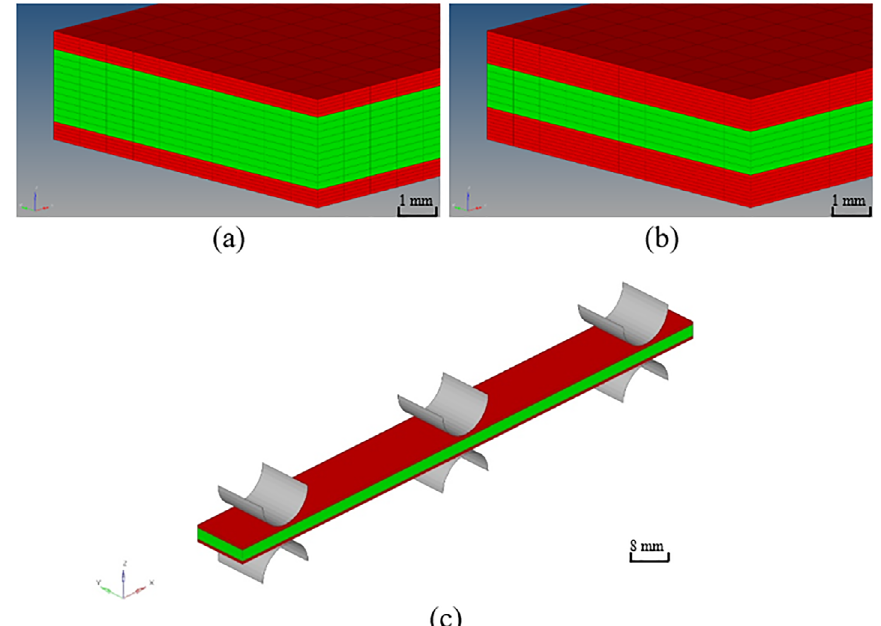
Figure 4. Finite Elements Model of the specimens, (a) SC3L and (b) SC5L and (c) three-point bending supports.